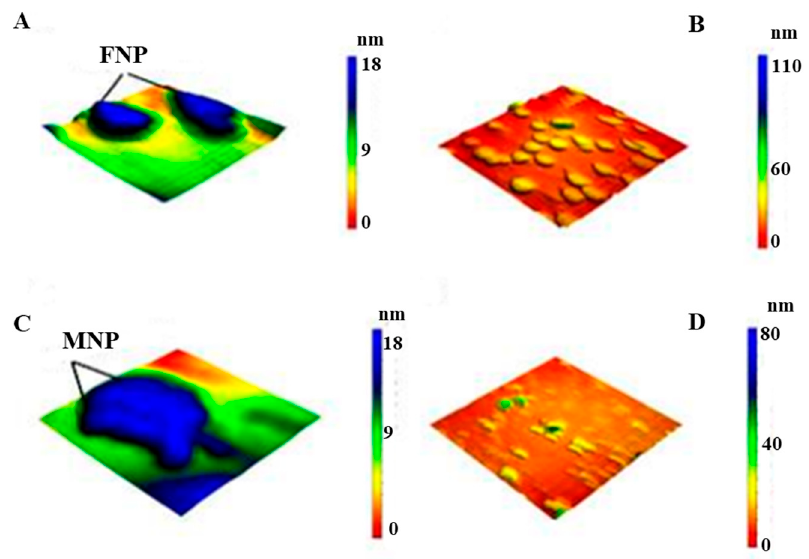
Figure 6. The three-dimensional form of Atomic Force Microscope (AFM) images of 50 × 50 nm of ( A ) FNP, ( B ) Ag-FNP, ( C ) MNP, and ( D ) Ag-MNP. The BET surface appeared to be 102.56, 69.64, 61.65, and 45.4395 m 2 /g for FNP, Ag-FNP, MNP, and Ag-MNP, respectively (Supplementary Figure S1). The decrease in BET surface area in some samples may be due to the formation of nanocomposites with AgNPs. All the samples showed V isotherms shapes (Supplementary Figure S2). The antibacterial activities of AgNPs, sole proteins (FNP and MNP), and protein nanocomposites (Ag-FNP, Ag-MNP) were studied against both Gram-positive and Gram-negative pathogenic bacteria (Table 1). All the tested antimicrobial agents (at MIC) showed antibacterial activity of significantly distinctive values ( p < 0.05). Both Ag-FNP or Ag-MP showed broader antibacterial activity than those obtained by either AgNPs or proteins (FNP and MNP). S. aureus (Gram-positive) and S. typhimurium (Gram-negative) appeared as the most sensitive organisms (Table 1 and Supplementary Figure S3). Table 1. Antibacterial activity of (at 1 MIC) AgNPs, FNP, MNP, Ag-FNP, and Ag-MNP. Treatment/Pathogenic Bacteria